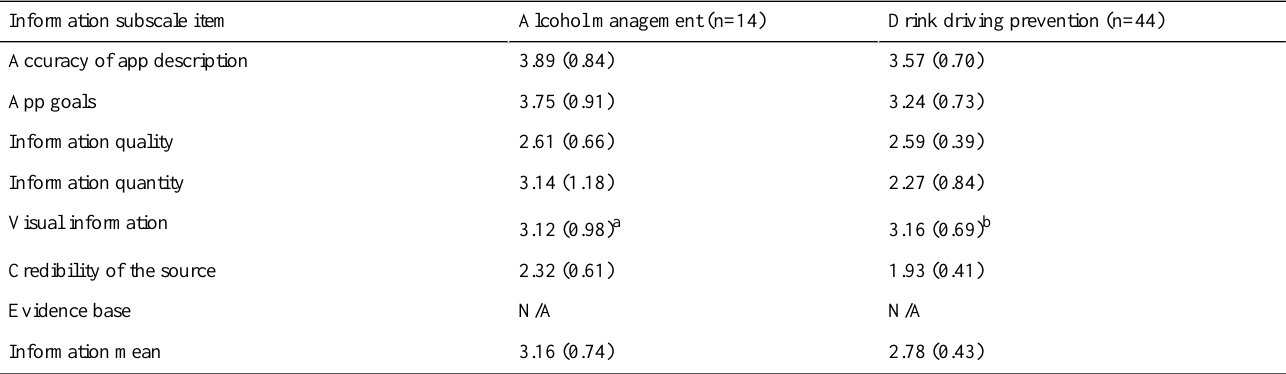
Table 3. Comparison of the MARS information subscale items overall mean scores and standrard deviations in parenthesis between alcohol management apps drink driving prevention apps .